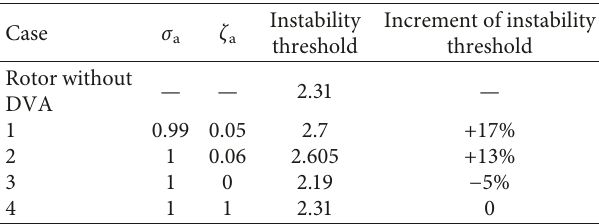
Figure 20: (a) The bifurcation diagram and (b) the amplitude-frequency response curve of the rotor/seal system attached with the DVA in the x coordinate when ζ a 1 and σ a 1. (cid:31) (cid:31) Table 1: The instability thresholds of the rotor/seal system under the four parameter combinations of the